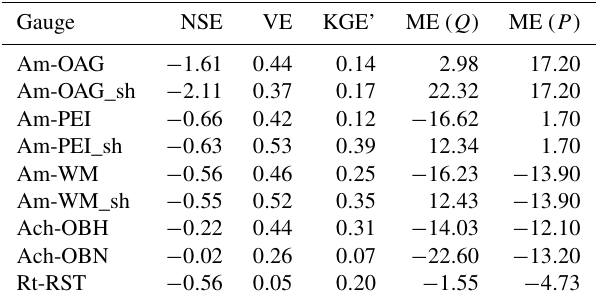
Table 9. Discharge performance measures for subcatchment gauges modeled with the fully coupled WRF-H_FC model for June to Oc- tober 2016. The gauges marked with sh denote the shifted discharge simulation results as applied in the WRF-H_SA calibration (Ta- ble 3). Mean errors (MEs) for Q (discharge) and P (precipitation) are given in millimeters per